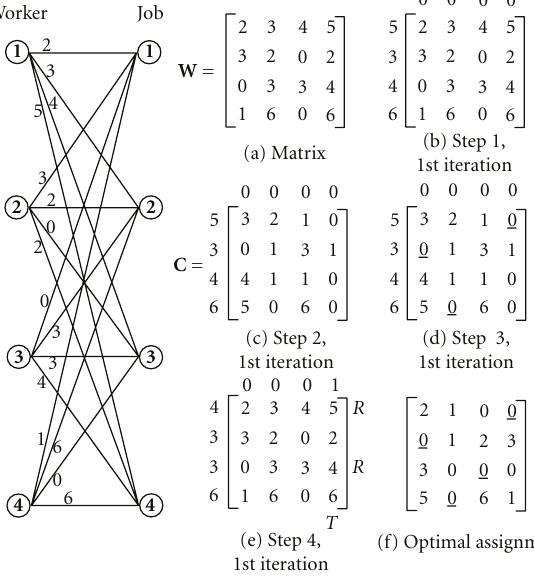
Figure 2: Weighted bipartite